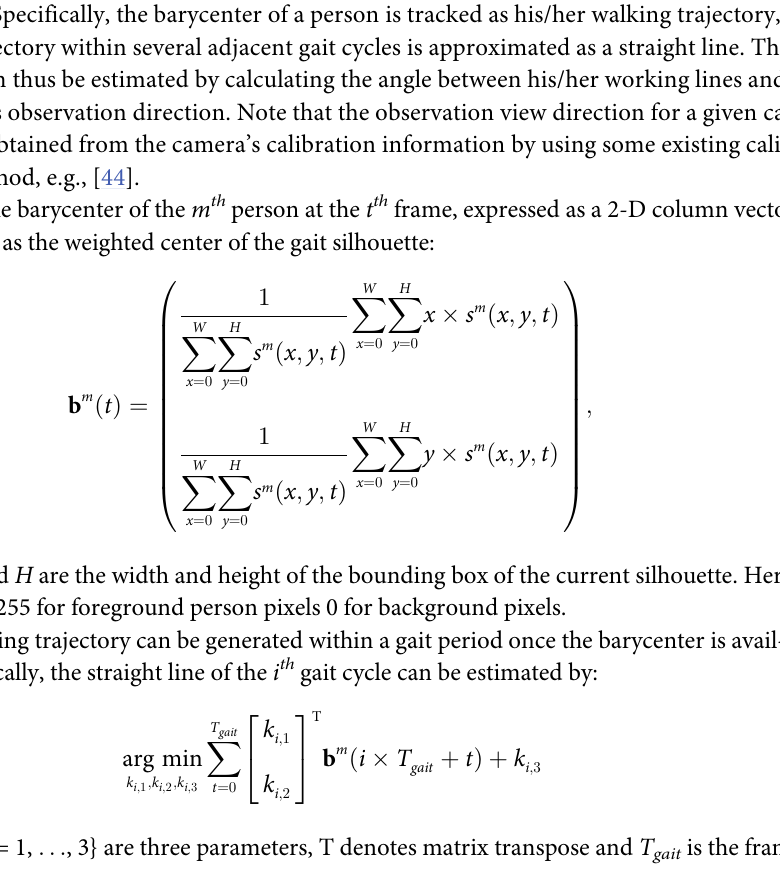
Algorithm 1 : The walking trajectory fitting (WTF) algorithm.